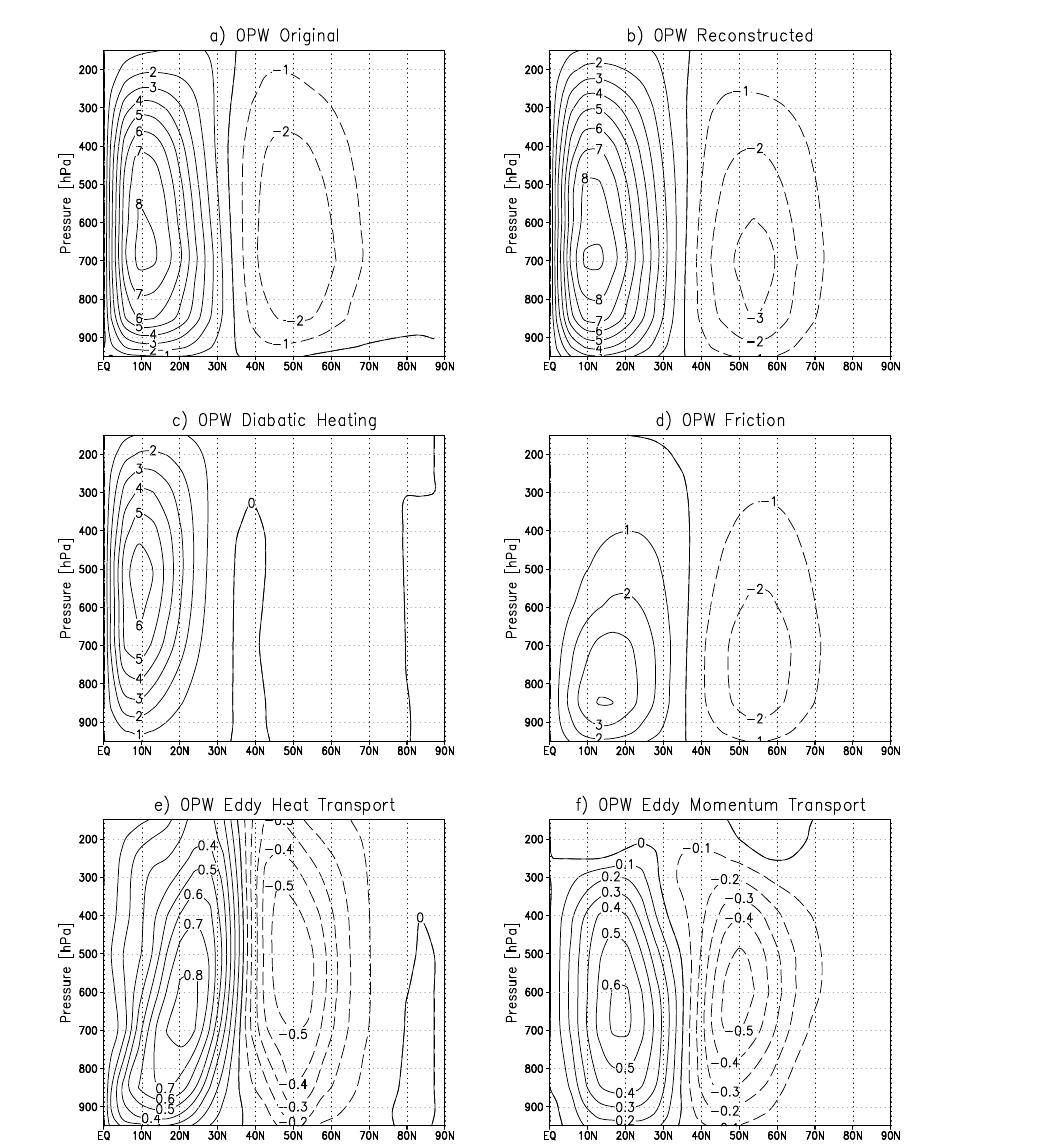
Figure 14. Climatological annual mean mass stream function (in 10 10 kgs − 1 ) for OHT max = 0PW: (a) original (see Fig. 12); (b) computed from the Kuo–Eliassen equation (all sources); (c) source from diabatic heating; (d) source from friction; (e) source from eddy heat transport; (f) source from eddy momentum